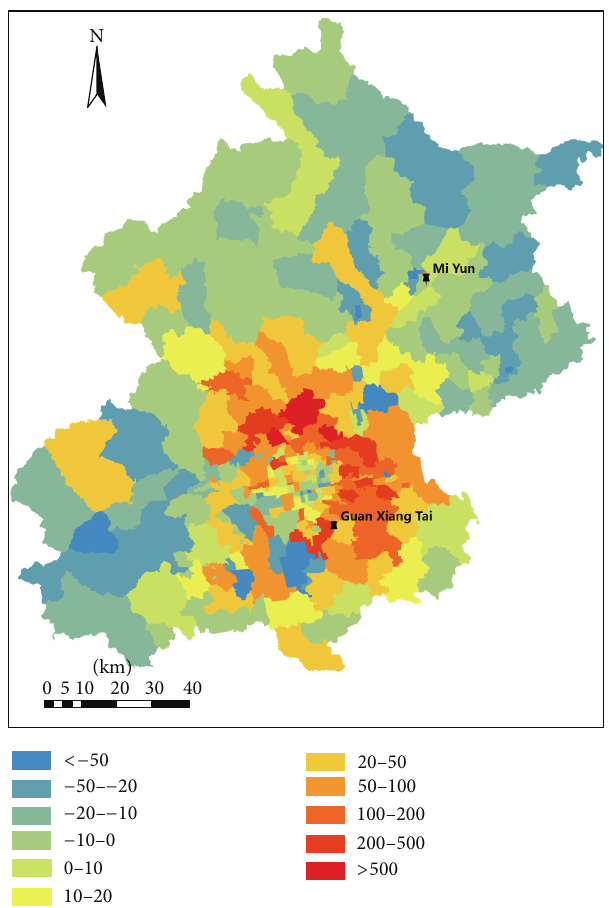
Figure 7: Population Growth Rate (PGR) of towns of Beijing in the period of